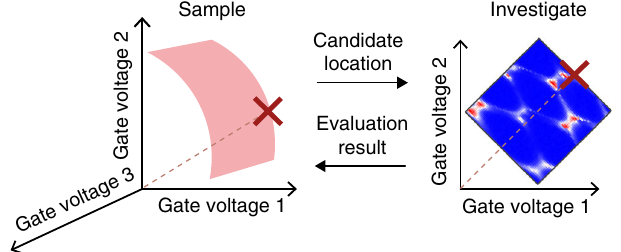
Fig. 2 Overview of the algorithm. The sampling phase stage produces candidate locations in gate voltage space, which are on the boundary hypersurface (pink surface). The distance between a candidate location (red cross) and the origin of the gate voltage space is marked with a dashed line. The investigation stage evaluates the local region by, for example, measuring current maps which are evaluated by a score function. (The current map displayed is an example of a measurement performed by the algorithm. It uses a colour scale running from red, the highest current measured, to blue, the lowest current). Evaluation results are fed back to the sampling